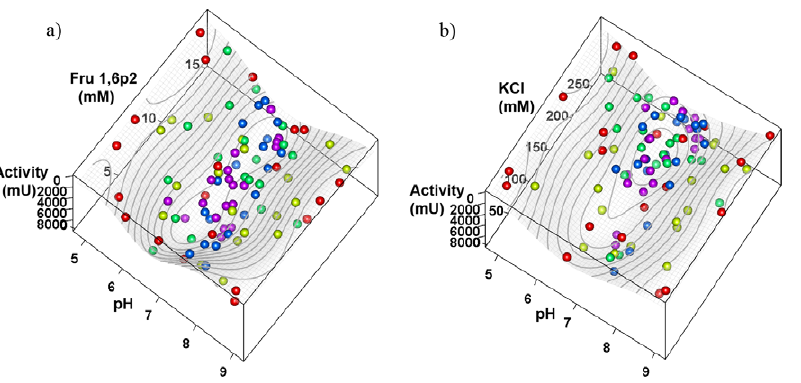
Figure 1. The final response-surface model and the measurements of the five optimization rounds (red, yellow, green, blue and purple). Data are presented as enzyme activity dependence on (a) Fru1,6P2 concentration and pH or (b) KCl concentration and pH. The interpolated response surface correspond to a slice of third variable (KCl in (a); Fru1,6P2 in (b)) at optimal condition. Note how the measurements of the later iterations cluster around the optimum, providing additional information about this